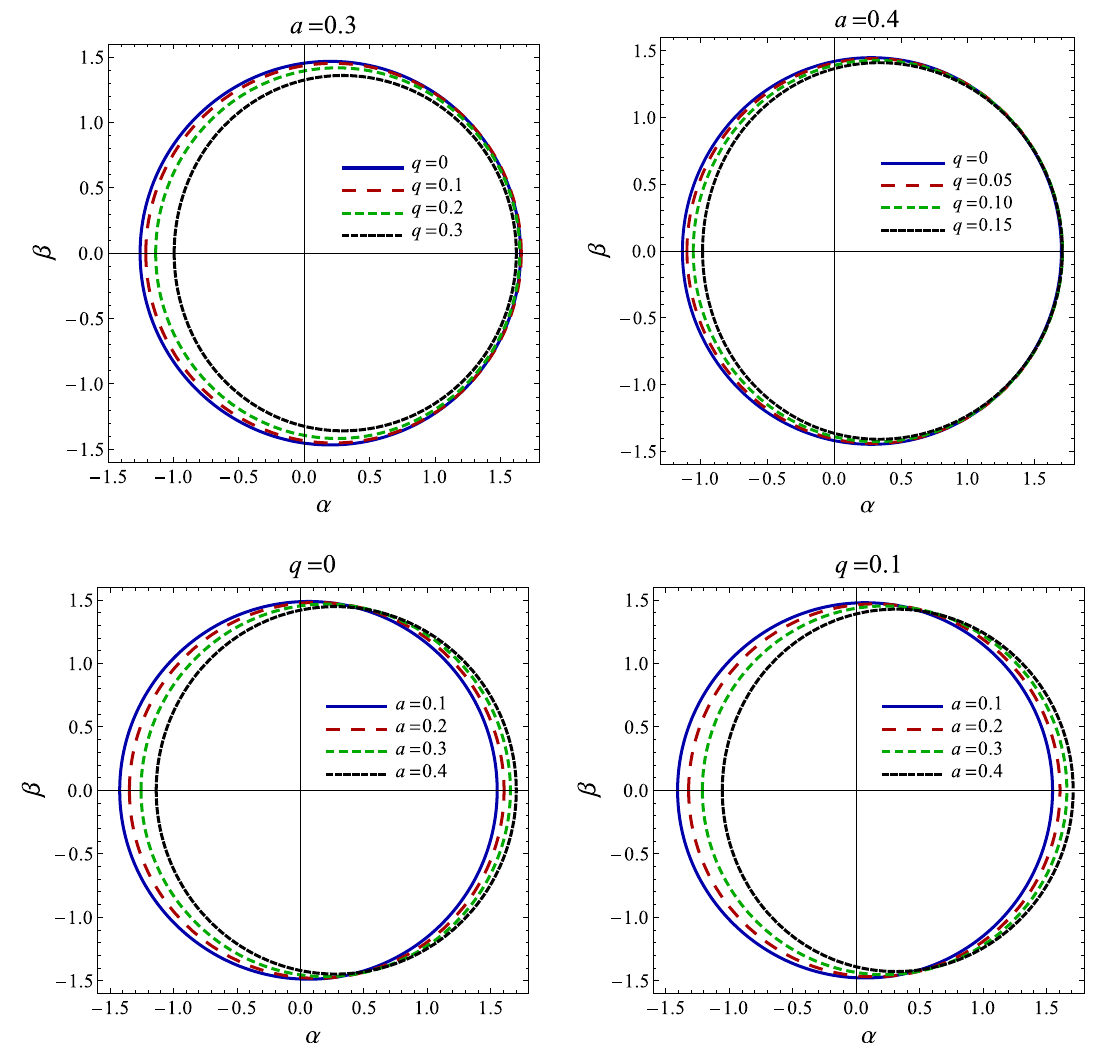
Fig. 5 Plot showing the shapes of shadows cast by five-dimensional EMCS black hole with inclination angle θ 0 = π/ 2 for different values of charge q and the spin a with the case q = 0 referring to the Myers–Perry black hole gularity shadow forms an arc instead of a circle (cf. Fig.